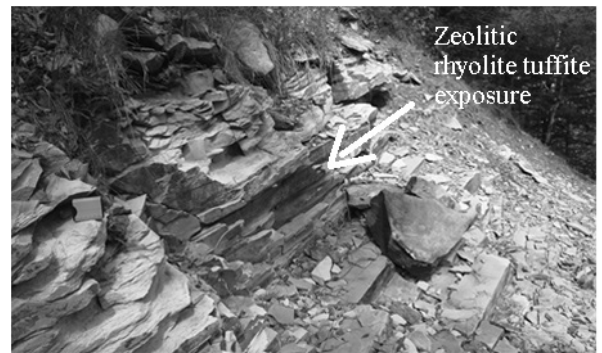
Figure 3. Zeolitic rhyolite tuffite exposure with the marks of active usage of rocks by wild animals (kudur no. 9, the Vanchinskaya coal- bearing basin).